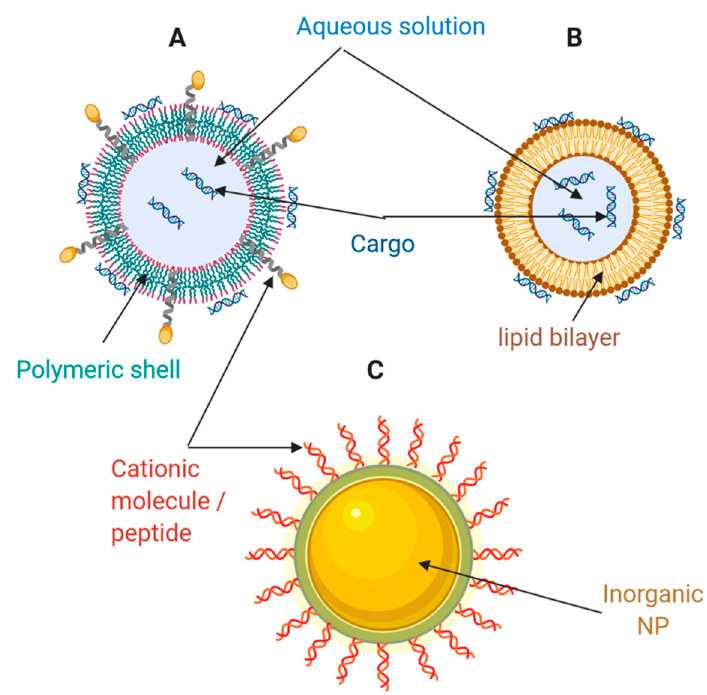
Figure 3. Schematic of different types of nanocarriers for drug and gene delivery. ( A ) Polymeric nanoparticle; ( B ) Liposome; ( C ) Inorganic nanoparticle. Adapted from Weng et al. [90], Molecular Therapy Nucleic Acids,